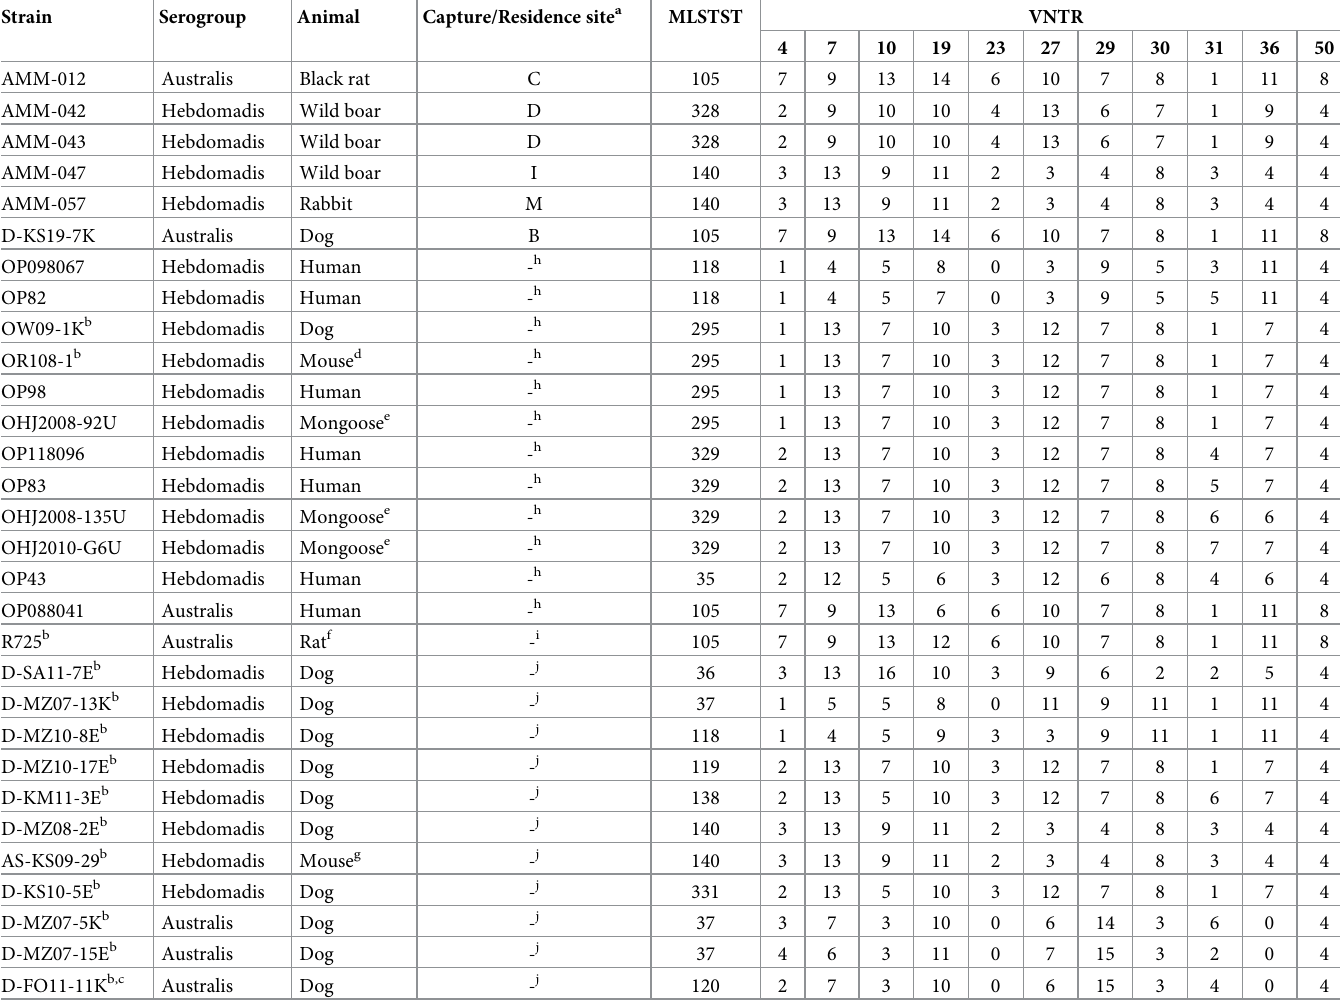
Table 2. STs and MLVA profiles of L . interrogans isolates analyzed in this study.